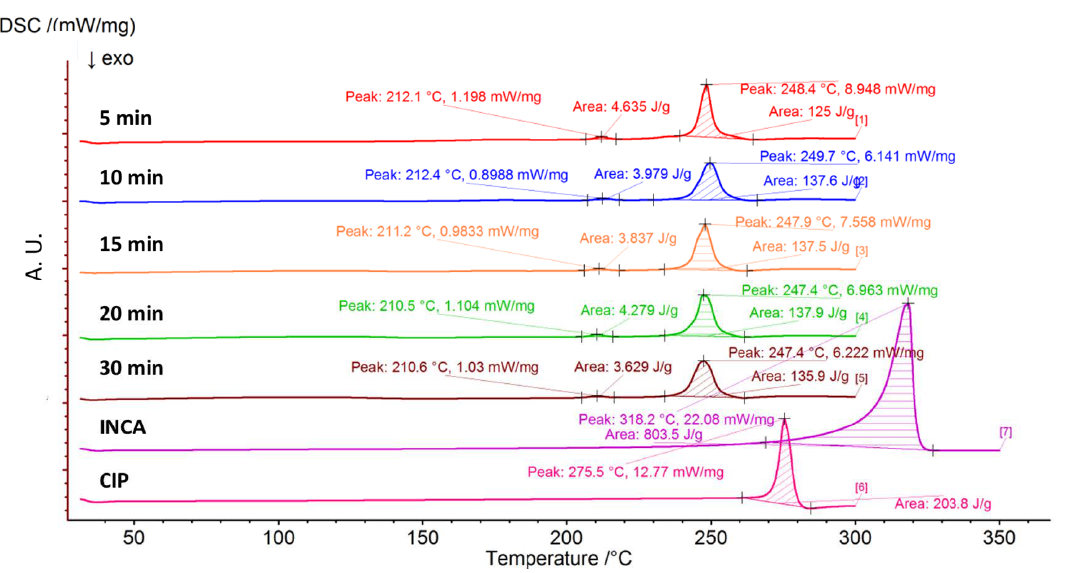
Figure 5. DSC thermogram of ground samples for various duration of times.